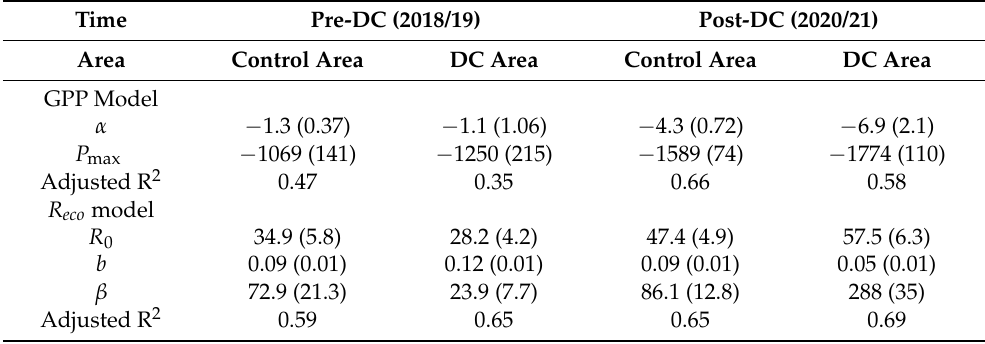
Table 1. Model parameters for estimating gross primary production (GPP) (Equation (3)) and ecosystem respiration ( R eco ) (Equation (4)) for control and ditch cleaning (DC) clear-cut area, applied separately in the pre-DC years (2018/19) and post-DC years (2020/21); α is the initial slope of the light- use photosynthetic efficiency (mg µ mol − 1 photons of CO 2 -C); P max is the maximum photosynthetic rate at light saturation (mg m − 2 h − 1 of CO 2 -C); R 0 is respiration rate (mg m − 2 h − 1 of CO 2 -C) at 0 ◦ C; b is the sensitivity of R eco to soil temperature (T s ); β represents the contribution of autotrophic respiration to R eco ; numbers in parentheses indicate standard error; R 2 denotes the coefficient of determination of the model. Number of observations ranges between 186 and 272 for the development of each model. Pre-DC